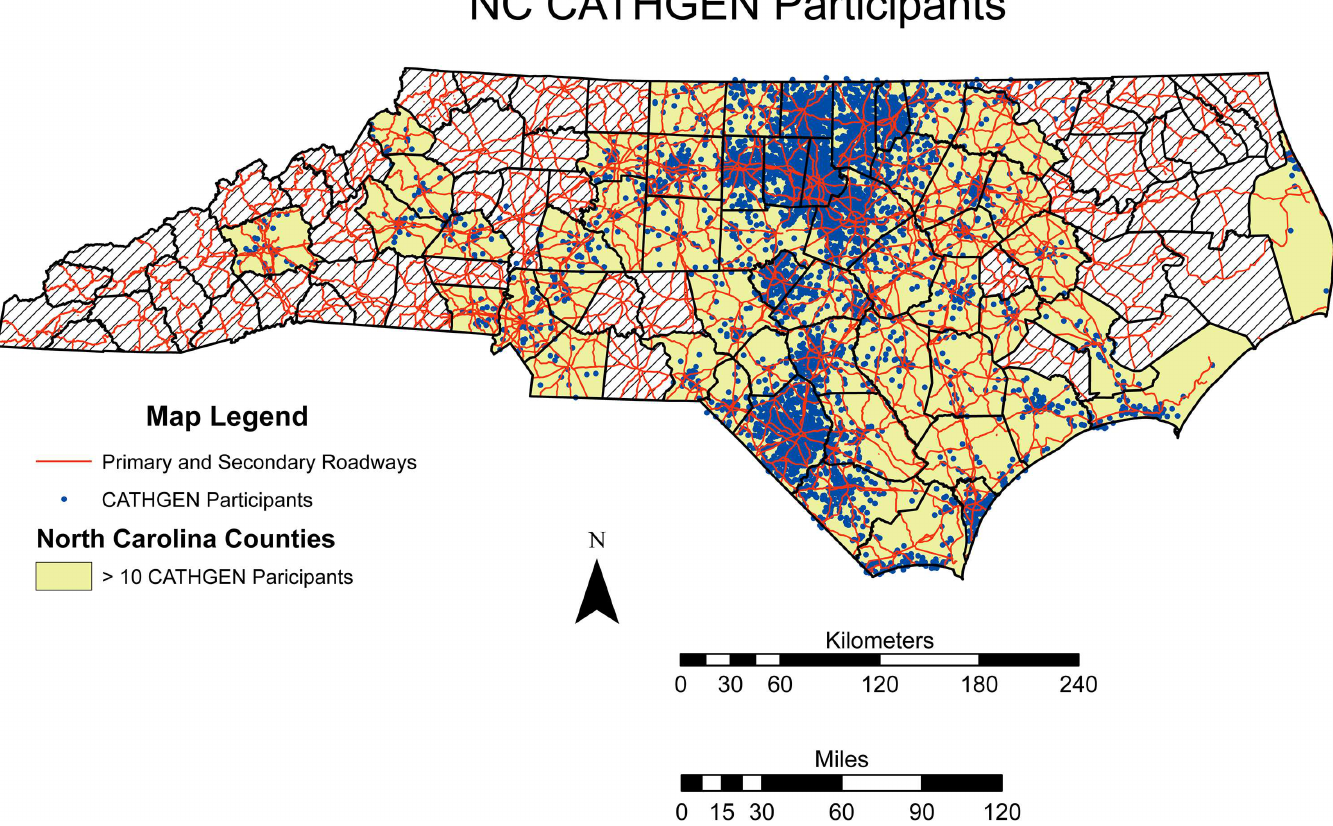
Fig 1. NC CATHGEN Participants. The distribution of CATHGEN participantsoverlaidwith the primary and secondary roadwaynetwork (red lines) for North Carolina. To protect patient health information countieswith 10 or fewer participantsare suppressedand representedby hatch marks. All other countieshave the CATHGEN participantslocations(blue dots) randomized within a small area to preservethe overall structure and still protect patient health information.